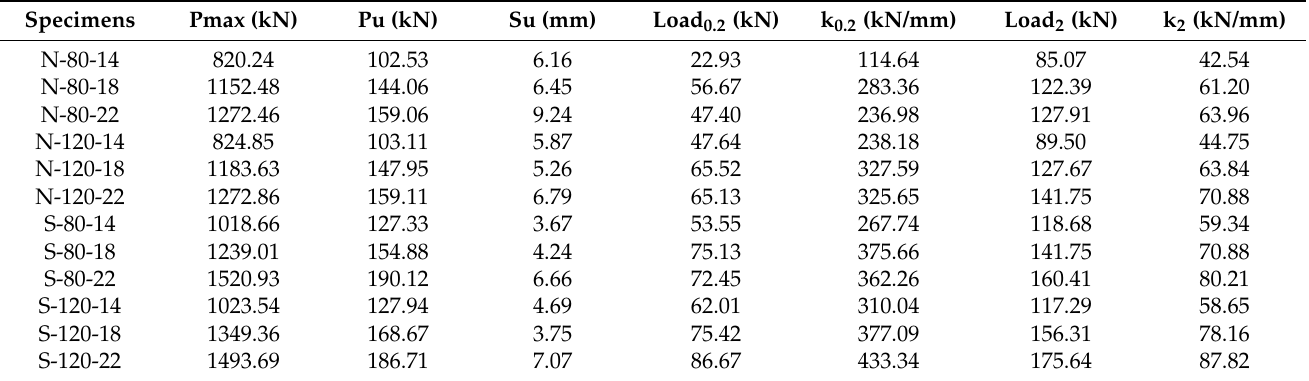
Table 5. Push-out test